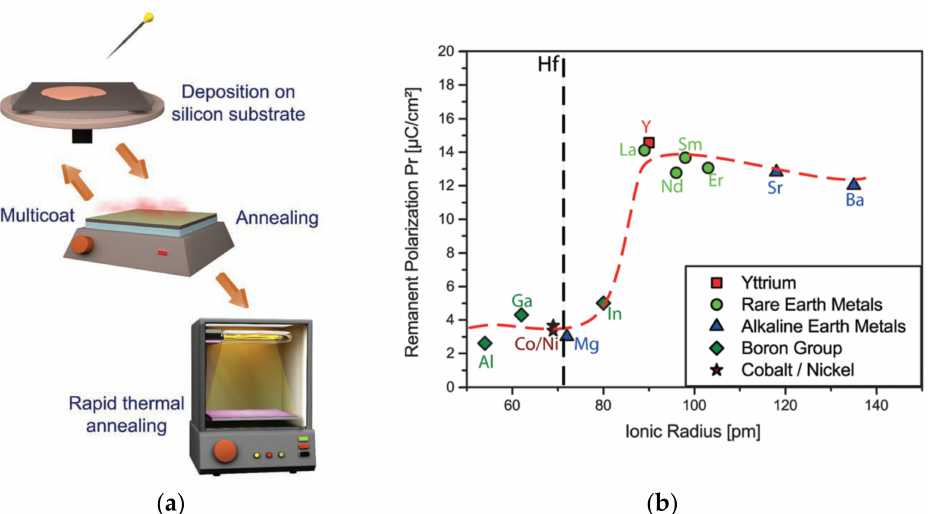
Figure 3. ( a ) Workflow for sample preparation. Reproduced with permission. [54] Copyright 2021, Wiley-VCH. ( b ) remanent polarization depending on the ionic radius of various dopants [55]. Copyright 2017, The Royal Society of